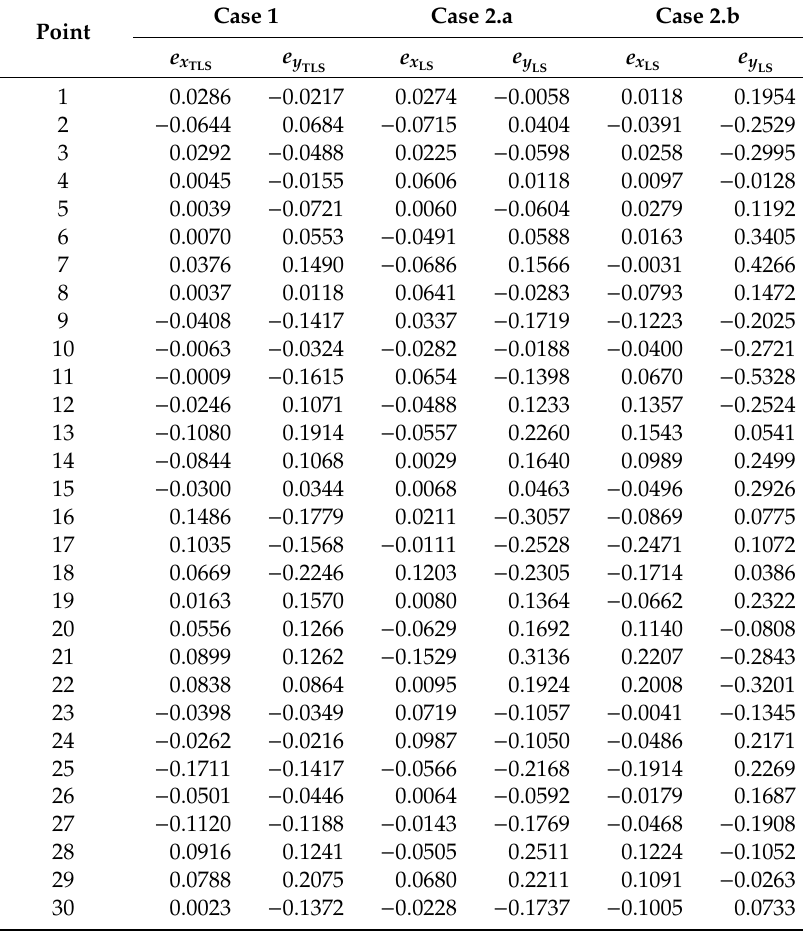
Table 2. Error components from TLS and LS spline approximation.